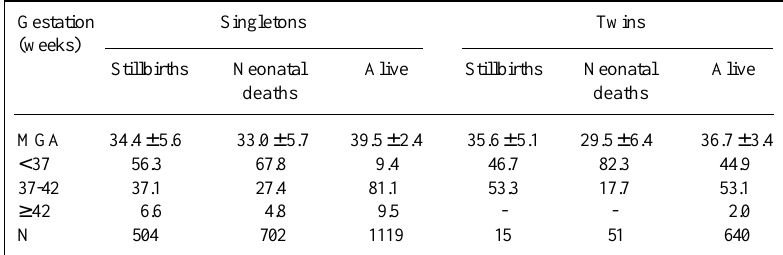
Table V - Mean gestational age (MGA) in weeks and percentage of preterm (< 37 weeks), term (37-42 weeks) and post-mature ( ‡ 42 weeks) newborns among singletons and